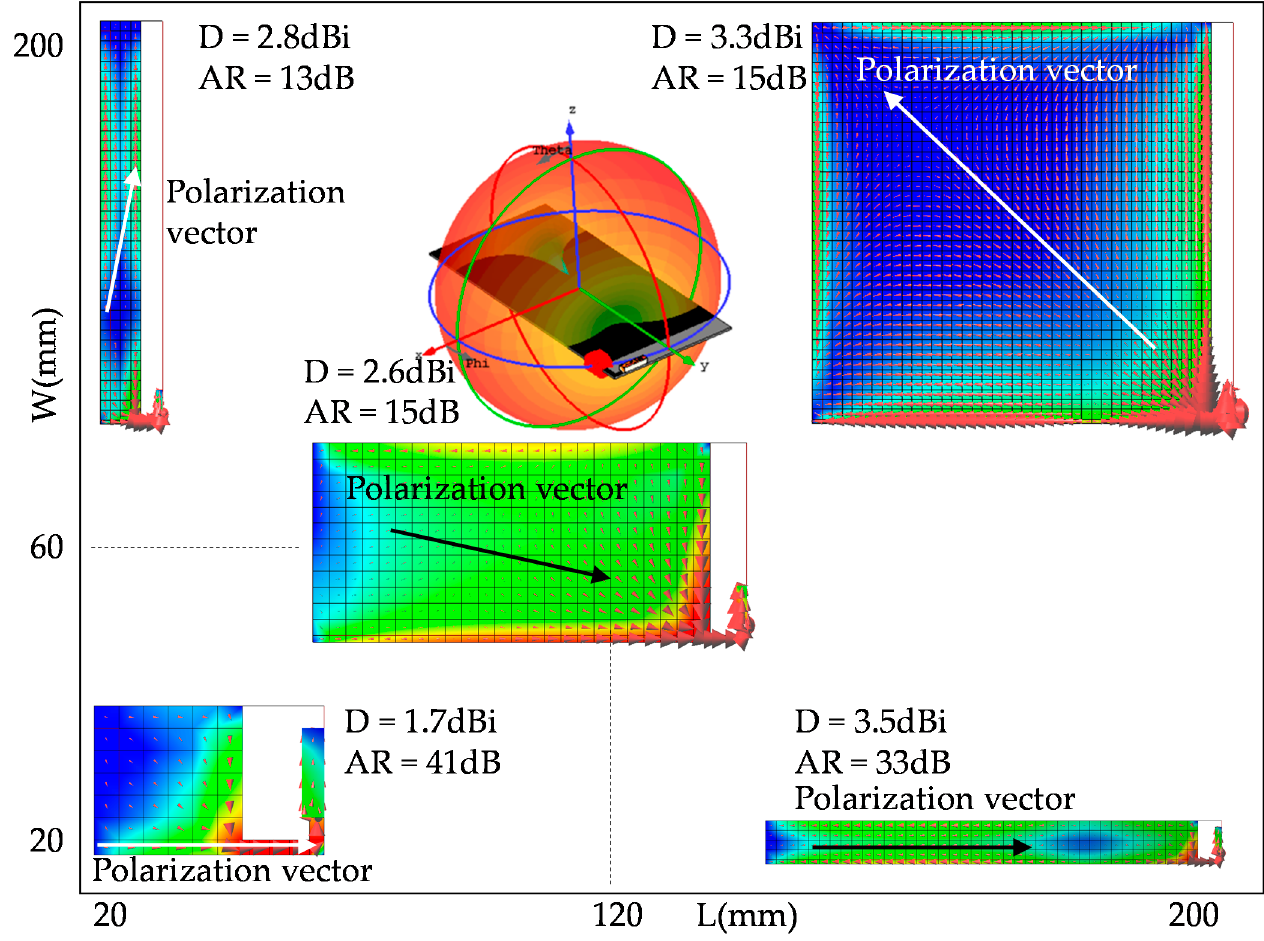
Figure 10. Simulated current distribution, directivity, and the axial ratio at 900 MHz for the 20 mm × 20 mm, 20 mm × 200 mm, 200 mm × 20 mm, 120 mm × 60 mm, and 200 mm × 200 mm ground planes. AR is the axial ratio for θ = 0° (direction perpendicular to the ground plane). The arrows indicate the direction of the polarization vector. The 3D radiation pattern is represented in dB with a dynamic range of 30 dB at 900 MHz for the 120 mm × 60 mm ground plane.